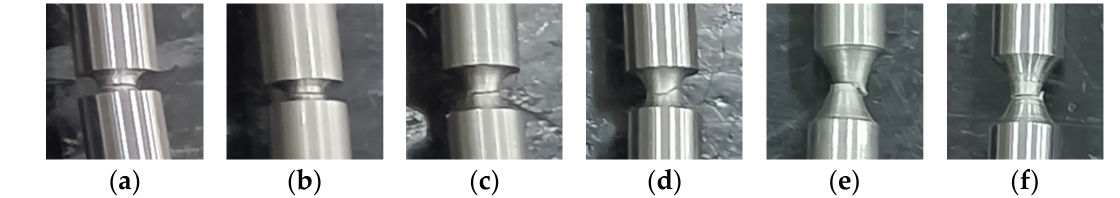
Figure 4. Fracture topography of notched round bars: ( a ) RN-1 (1.5 mm), ( b ) RN-2 (1.5 mm), ( c ) RN-3 (3.125 mm), ( d ) RN-4 (3.125 mm), ( e ) RN-5 (6.25 mm), ( f ) RN-6 (6.25 mm).